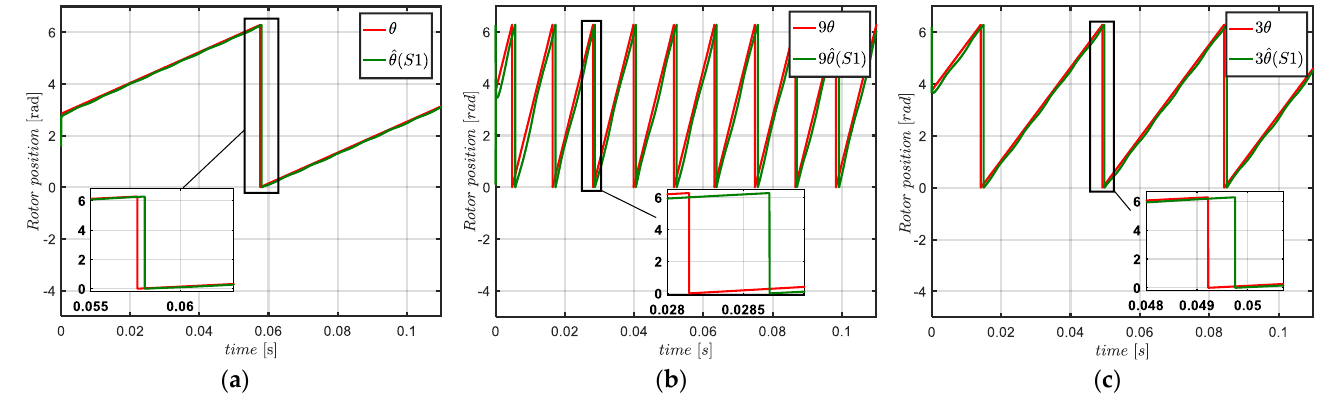
Figure 8. Simulation waveforms of the actual and estimated rotor position through ( S1 ): ( a ) angle required to control MM, ( b ) angle required to control SM, ( c ) angle required to control TM.